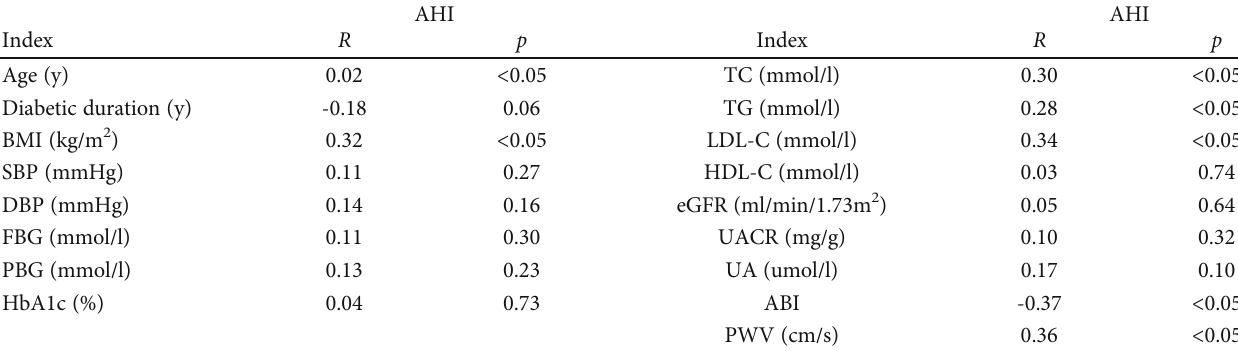
Table 2: Linear correlation analysis between AHI and general characteristics, biochemical indices, ABI, and